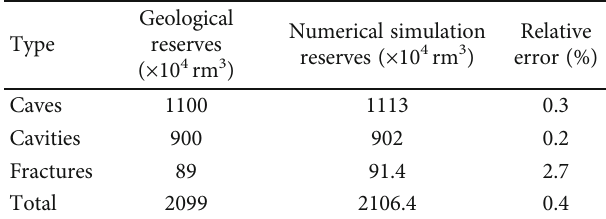
Figure 3: Reserve fi tting porosity correction. Table 2: L11 unit reserve fi tting